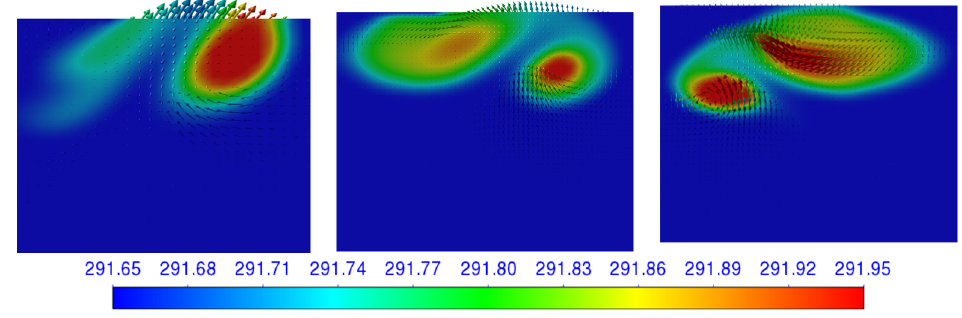
Figure 19. Temperature cloud diagram and velocity vector diagram of three sections.